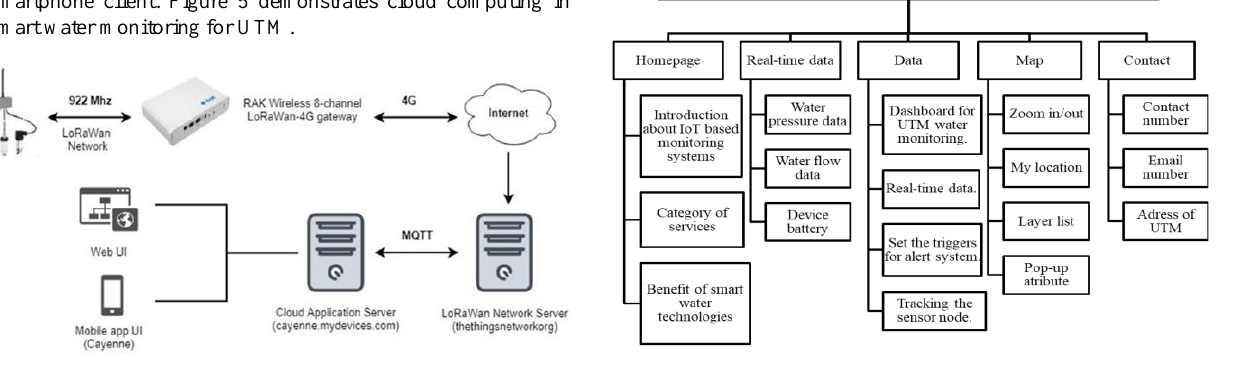
Figure 7. Application Interface Design for Web-based GIS for Smart Water Monitoring in